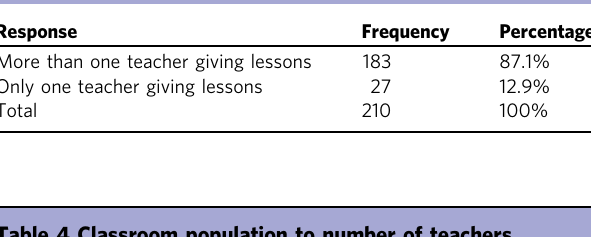
Table 3 Co-teaching in a montessori classroom.